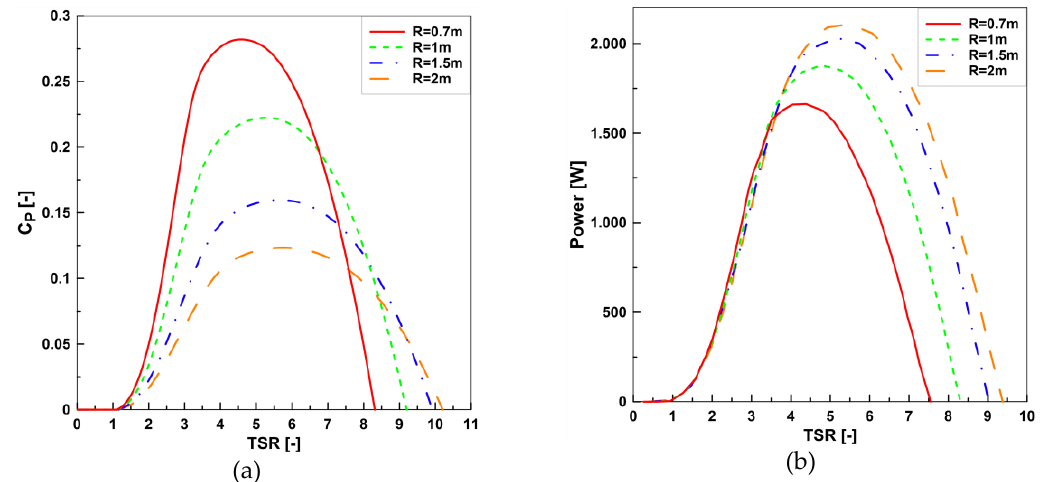
Figure 13. ( a ) Power coefficient Cp versus TSR for different radius; ( b ) Mechanical Power versus TSR for different radius